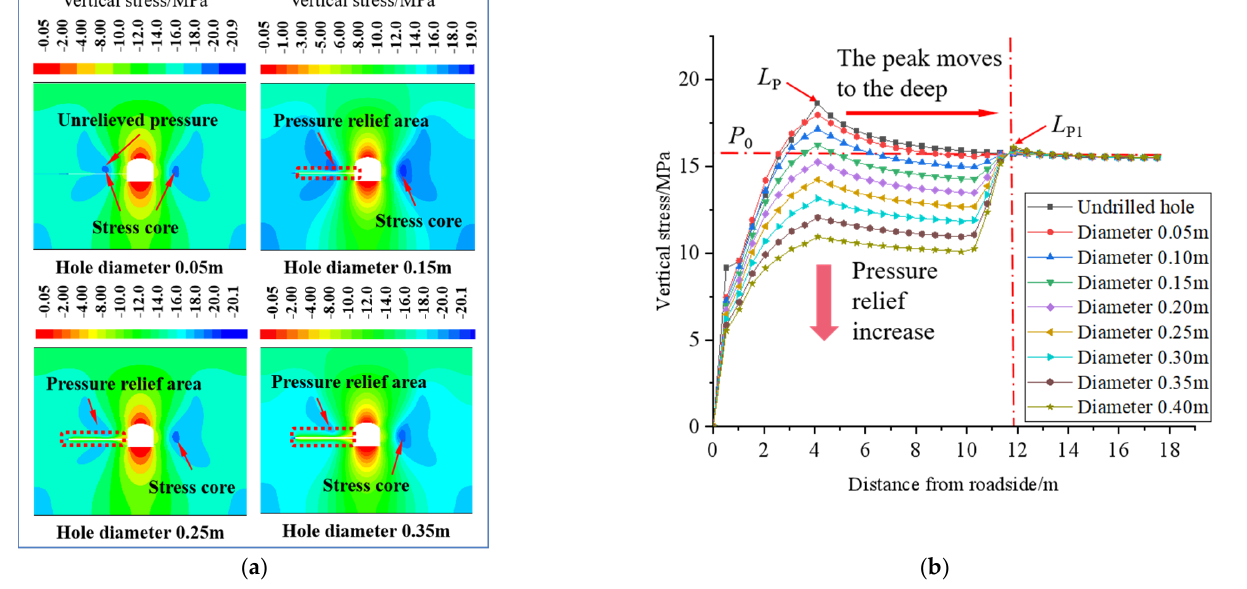
Figure 4. Pressure relief characteristics of the large − diameter borehole with different hole diameters. ( a ) Evolution characteristics of the stress contour plot with different hole diameters. ( b ) Evolution characteristics of the stress curves with different hole diameters.